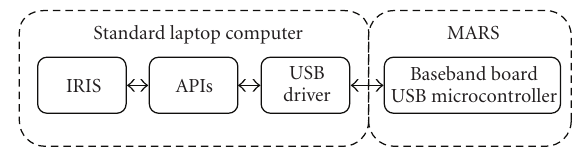
Figure 6: Computer to MARS transceiver